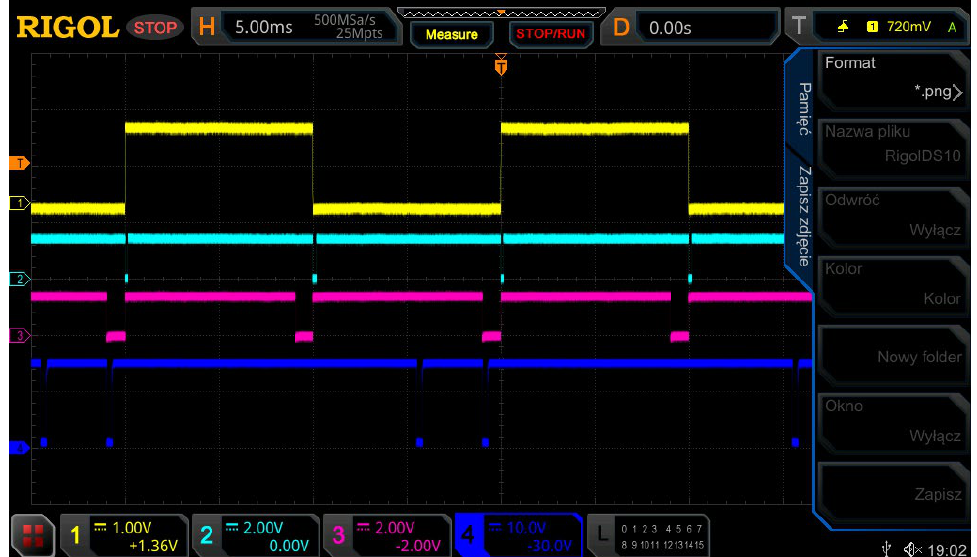
Figure 16. Synchronization signals of the RMF rectifier in the energy recovery circuit.